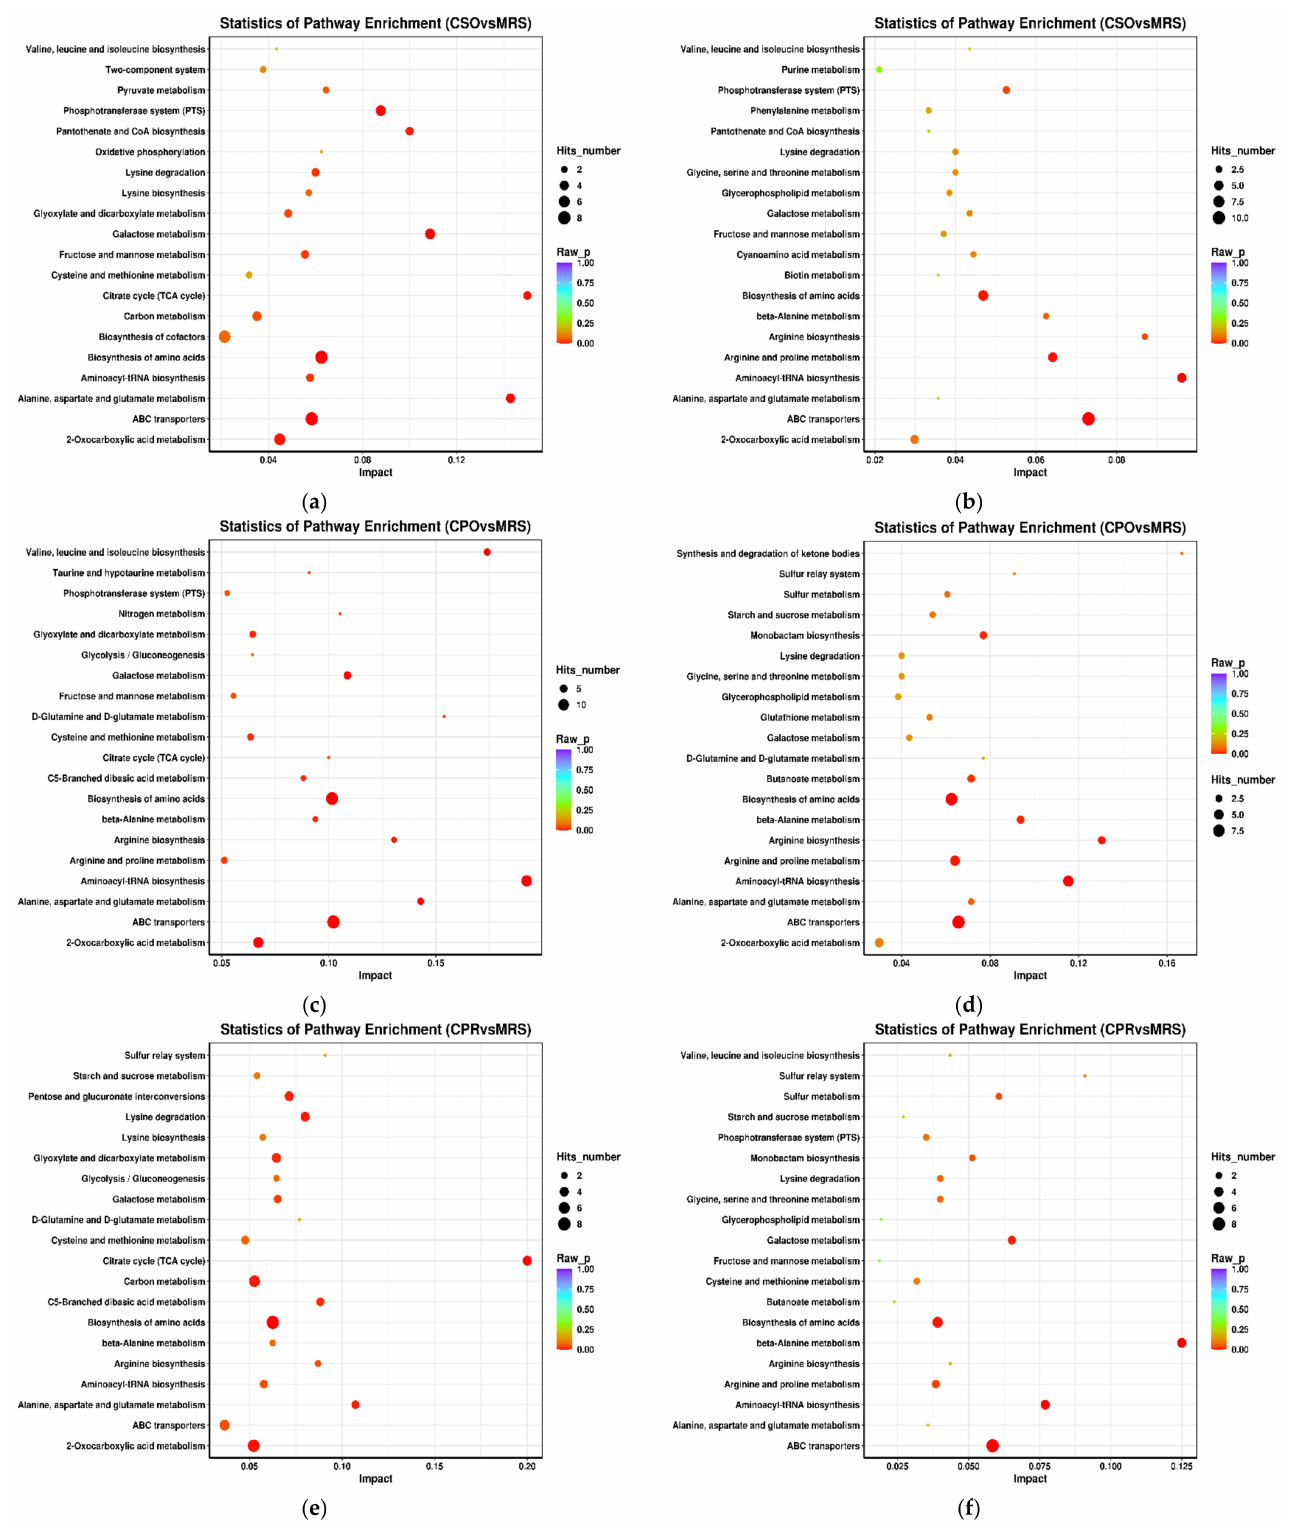
Figure 6. Metabolite enrichment pathway analysis of L. reuteri in the medium supplemented with CSE under positive ion mode and negative ion mode. Positive ion mode: ( a ) (CSO vs. MRS), ( c ) (CPO vs. MRS), ( e ) (CPR vs. MRS). Negative ion mode: ( b ) (CSO vs. MRS), ( d ) (CPO vs. MRS), ( f ) (CPR vs. MRS). CSO: coix seed oil; CPO: coix seed polysaccharides; CPR: coix seed